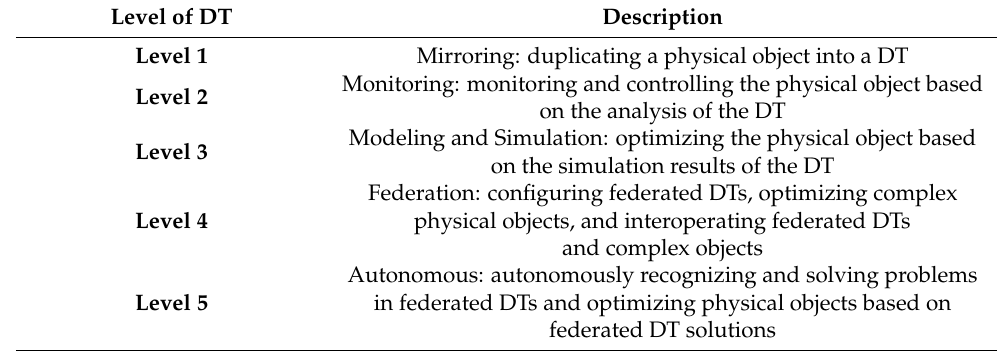
Table 1. Characteristics of a five level